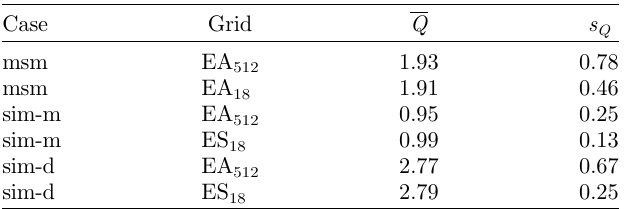
Table 6. Calculated directivity factor average Q and standard deviation s Q